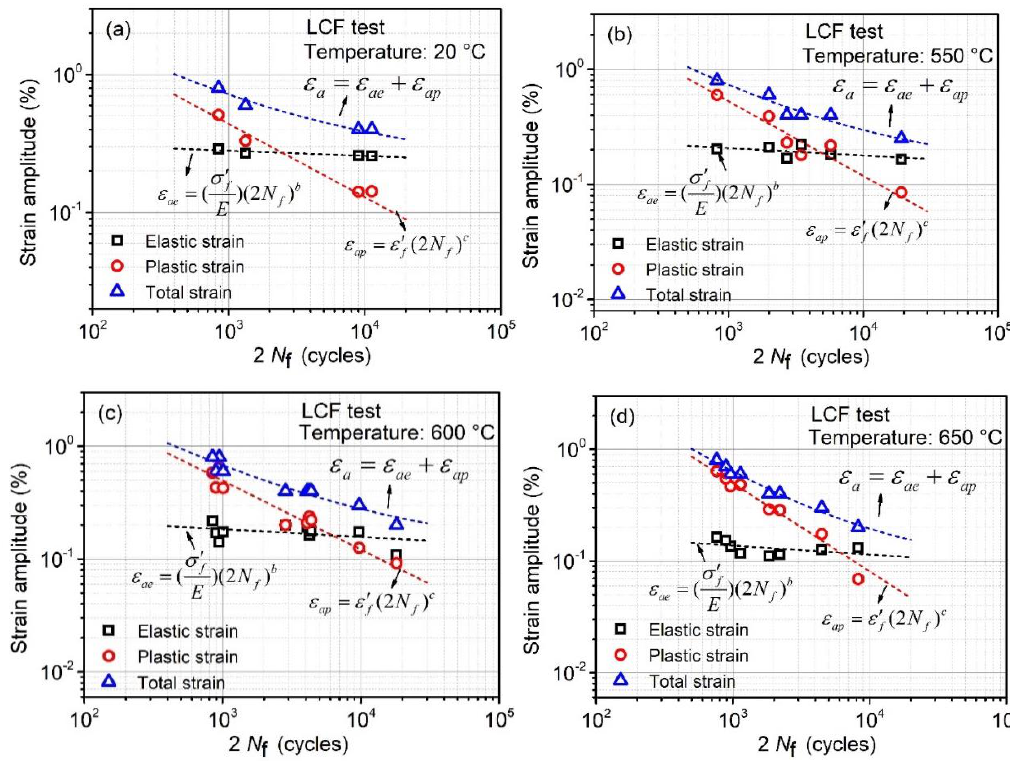
Figure 3. Strain amplitude versus cycle number of fatigue life at different temperatures: ( a ) 20 ◦ C, ( b ) 550 ◦ C, ( c ) 600 ◦ C, ( d ) 650 ◦